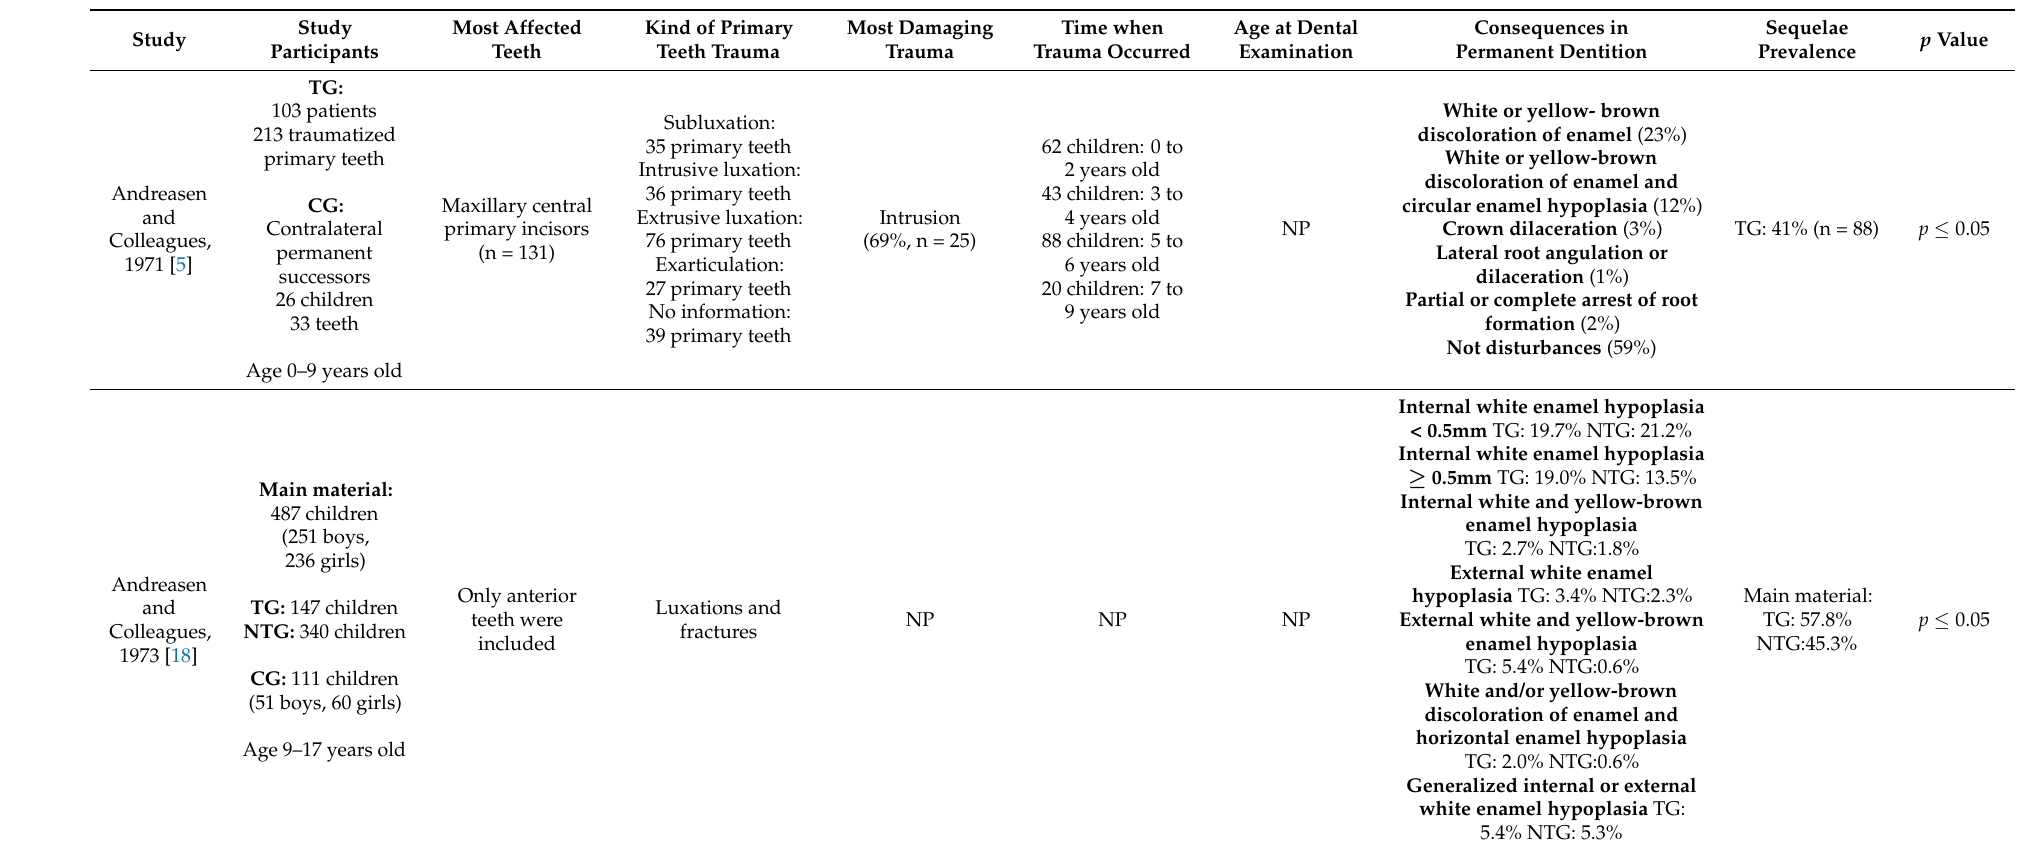
Table 4. Summary of the high-quality case-control